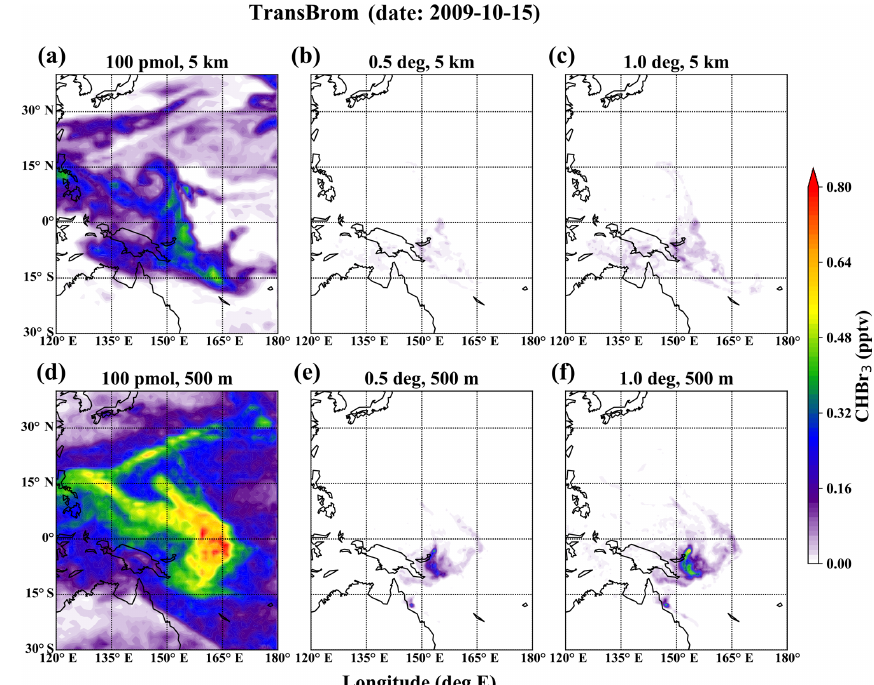
Figure 9. Atmospheric CHBr 3 mixing ratios at different altitudes (500m and 5km) simulated for the time period of the TransBrom campaign. Simulations are based on background emissions (a, d) and elevated emissions observed during the campaign for 0.5 ◦ (b, e) and 1 ◦ (c, f) wide emission grid cells.